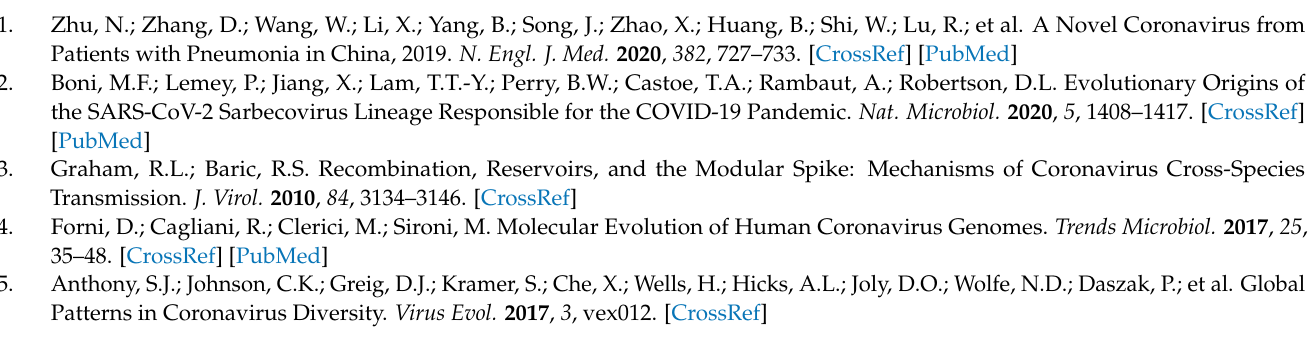
phylogenetic inference are labelled in black on this same right bar. (B) Phylogenetic tree of the relationship among viral strains. The tree is rooted based on an outgroup (grey) as indicated on Supplementary Table S2. Supplementary Figure S4: Scaterplot of the relationship between skweness of the folded site frequency spectrum (SFS) and coronavirus emergence time. The downward and upward triangles represent negative and positive skweness, respectively, and filled triangles represent skweness values significantly different from the null expectation. Supplementary Figure S5: Number of SARS-CoV2 sequenced genomes since the beginning of the outbreak, represented by bin of 10,000 sequences (top panel). Estimation of the SFS skweness, by subsampling five replicates of 1000 sequences within each bin (bottom panel). Supplementary Figure S6: Spearman correlation between relative abundance of CpG dinucleotide and coordinate of the first 4 principal components. Supplementary Figure S7: Spearman correlation between relative abundance of UpA dinucleotide and coordinate of the first 4 principal components. Supplementary Figure S8: Comparison of the CG3 content, CpG, and UpA dinucleotide relative abundances across CoVs hosts. Variance analysis of normally distributed data was carried out using ANOVA followed by a post doc Tukey test showing further individual pairwise differences. Non-normal data were processed using Kruskal–Wallis test follow by a rank Wilcoxon test with a Bonferroni correction (code for p -value: * <0.05, ** <0.01, *** <0.001). Supplementary Figure S9: Comparison of the CG3 content, CpG, and UpA dinucleotide relative abundances across CoVs genera. Variance analysis of normally distributed data was carried out using ANOVA followed by a post doc Tukey test showing further individual pairwise